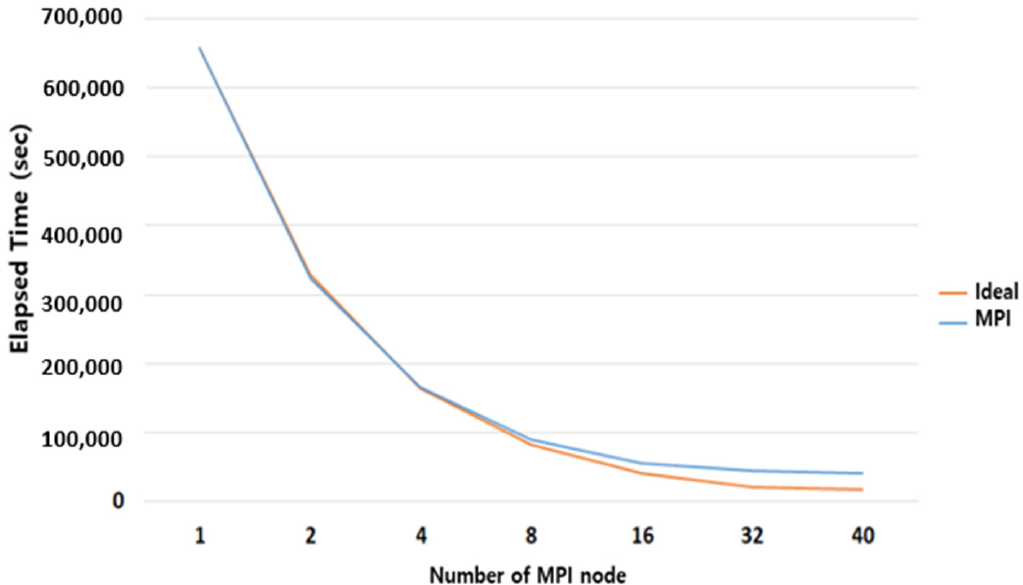
Figure A2. Execution time as a function of the number of MPI nodes. (3) Hybrid Parallel Performance Evaluation.